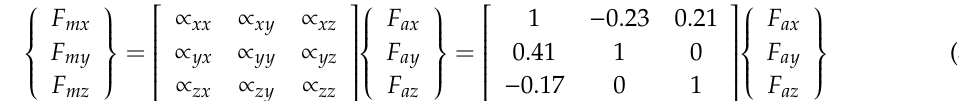
Figure 10. Cross-shaped groove design for integrating strain gauges.